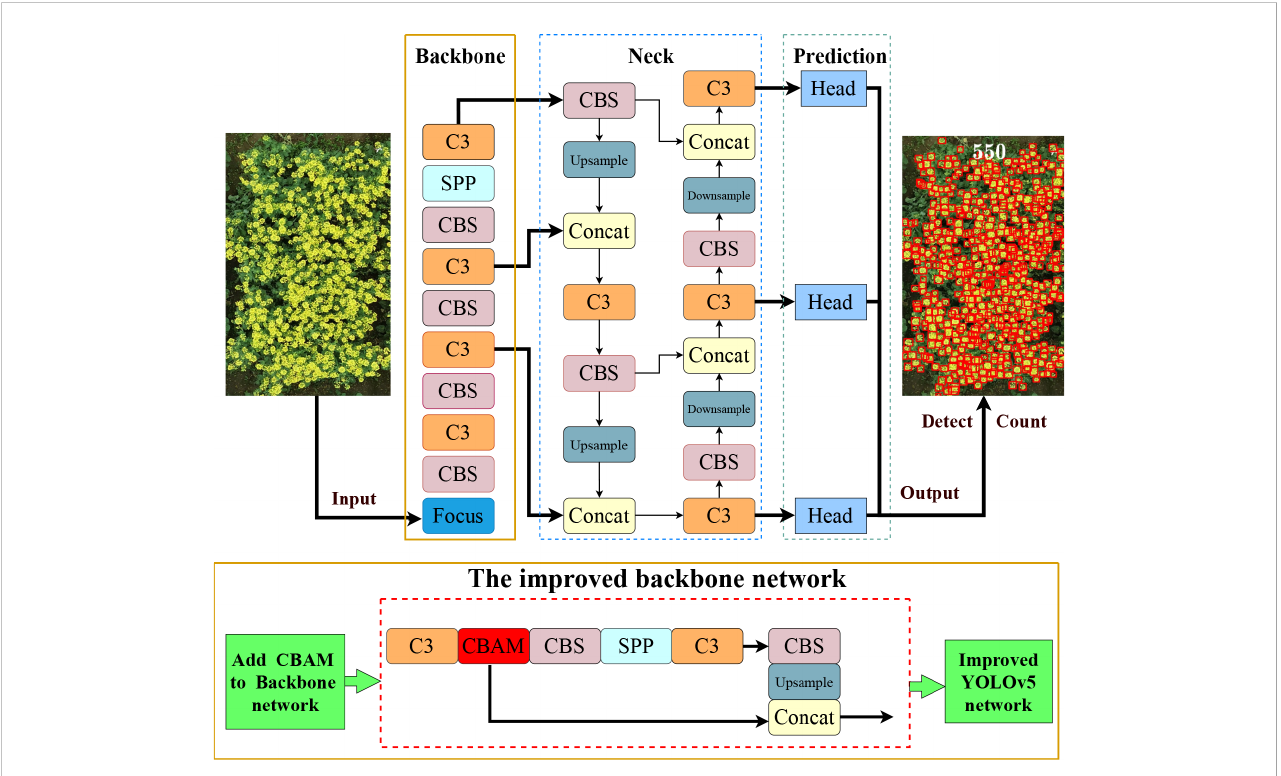
FIGURE 3 Network structure diagram of the proposed method. The upper part is the YOLOv5 model, and the lower part is the improved backbone network and composition of each module. The improved YOLOv5 generated detection map with the number of rapeseed in fl orescences after inputting a rapeseed